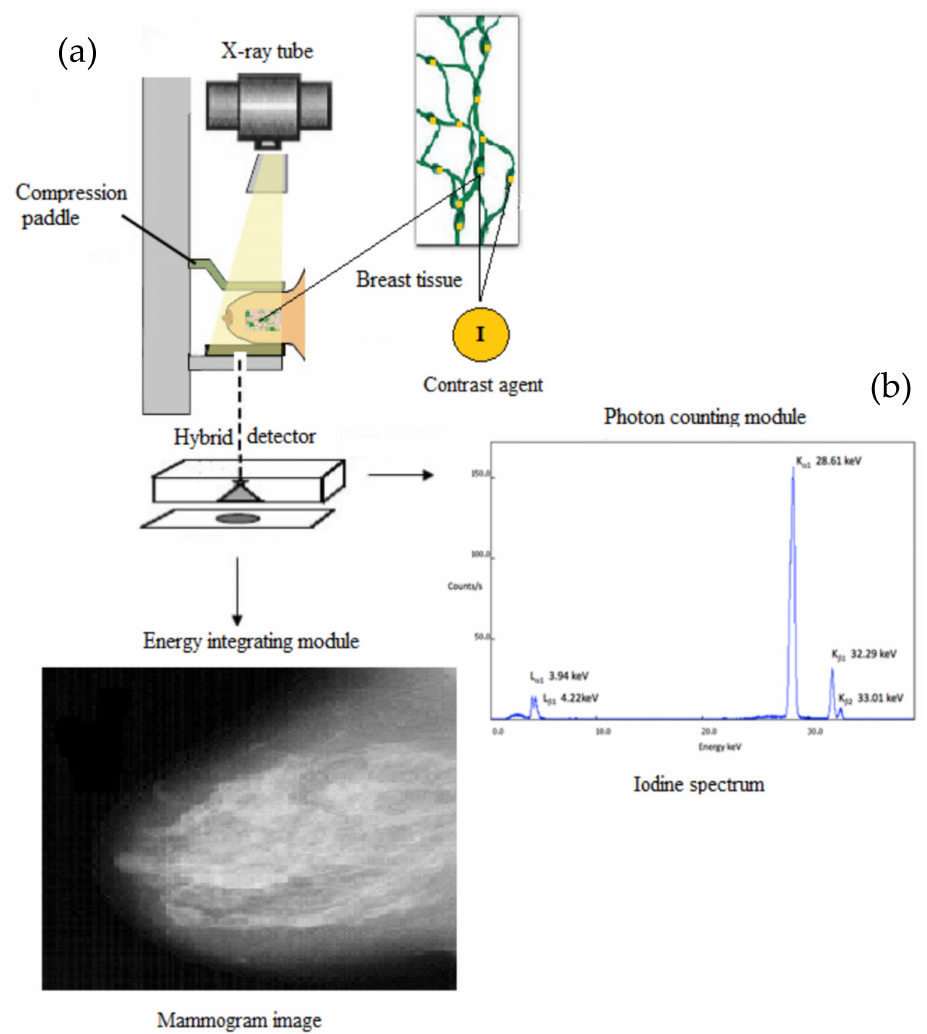
Figure 1. The hybrid detective system consists of: ( a ) the energy integrating module with the purpose of obtaining and characterizing the morphological imaging features; and ( b ) the photon-counting module with the purpose of obtaining and characterizing the functional imaging features by counting the K-characteristic radiation emitted by the contrast agent (the spectrum of the iodine contrast agent is